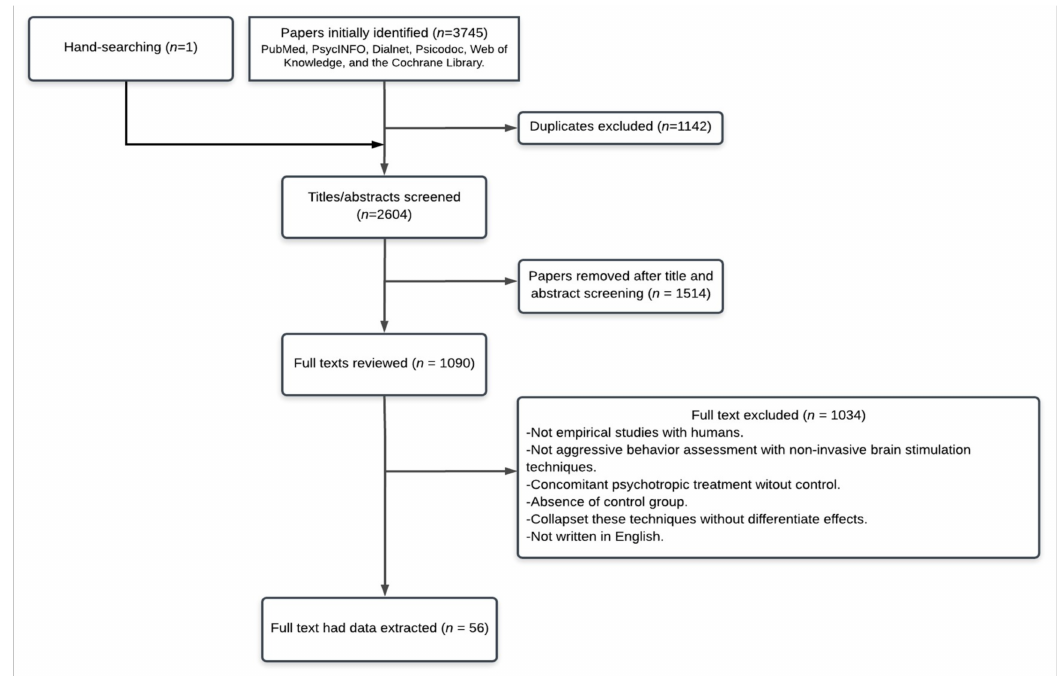
Figure 1. Flow chart of literature search with reasons for